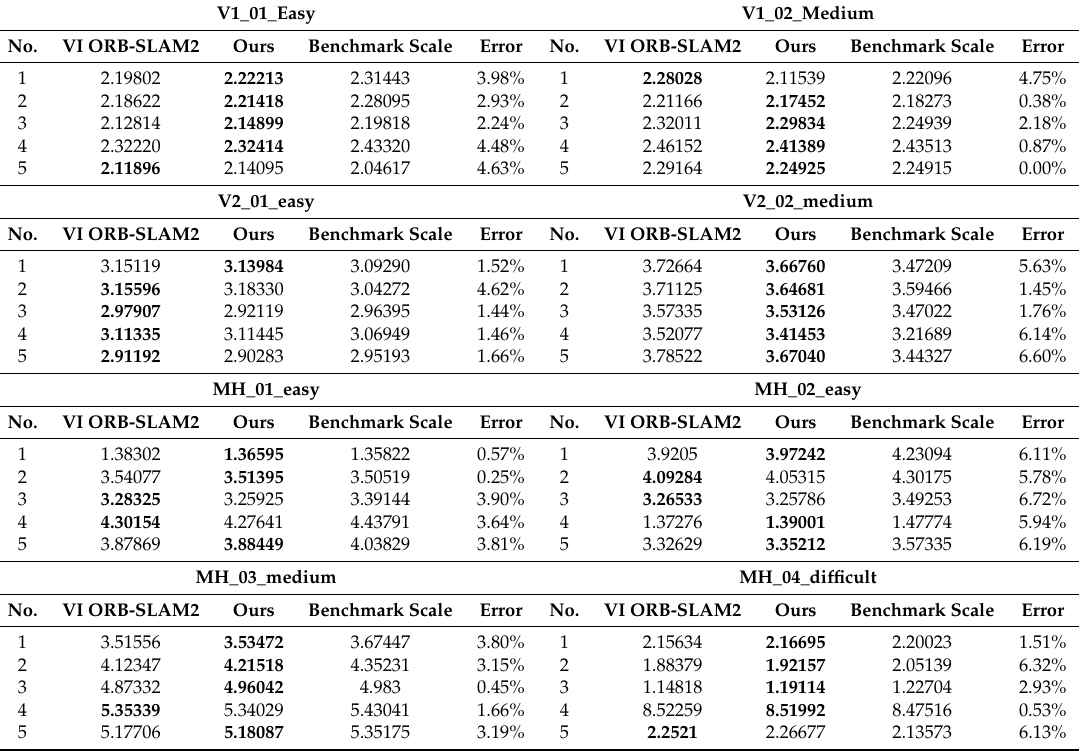
Table 1. The results of scale estimation, compared with the scale from visual–inertial ORB-SLAM2 (VI ORB-SLAM2) [8] and benchmark scale after VI ORB-SLAM2 system runs for 15 s. The fifth column shows the percentage of error between the estimated scale using our method and the benchmark scale. The numbers in bold represent the estimated scale is more close to the benchmark